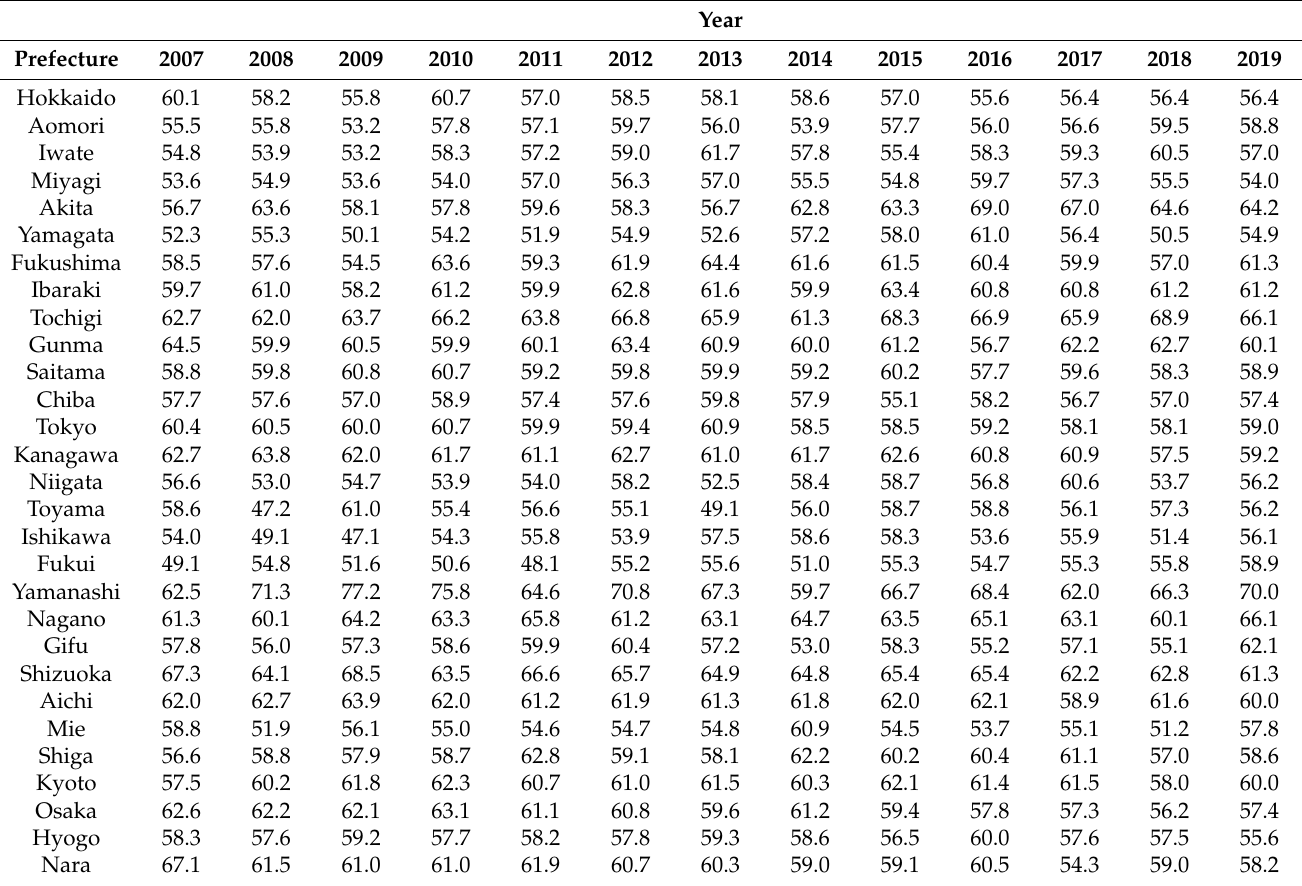
Table 3. Annual rate of term low birth weight per 1000 births for each prefecture.